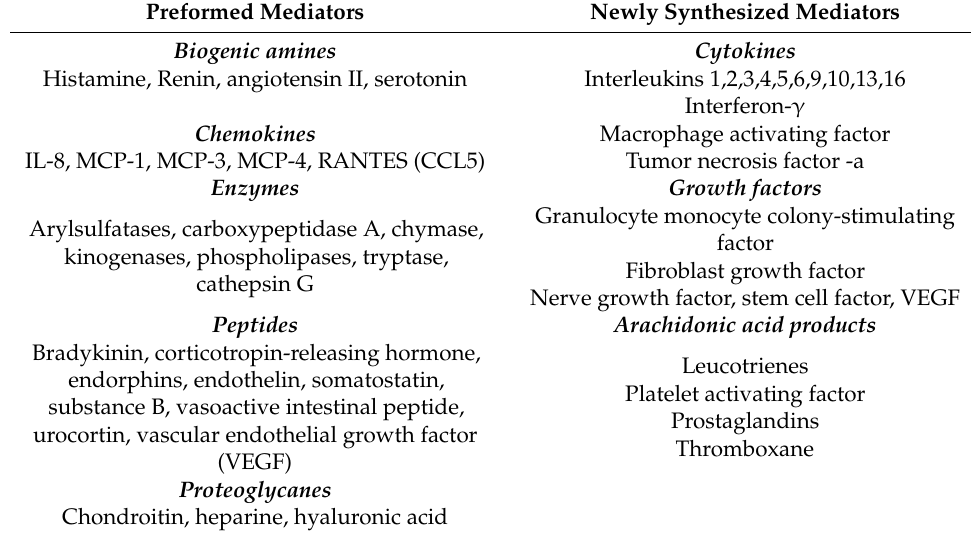
Table 5. Mast cell: the “pleiotropic cell”and its inflammatory mediators participating in “Cytokine storm” able to induce the Kounis syndrome. Preformed